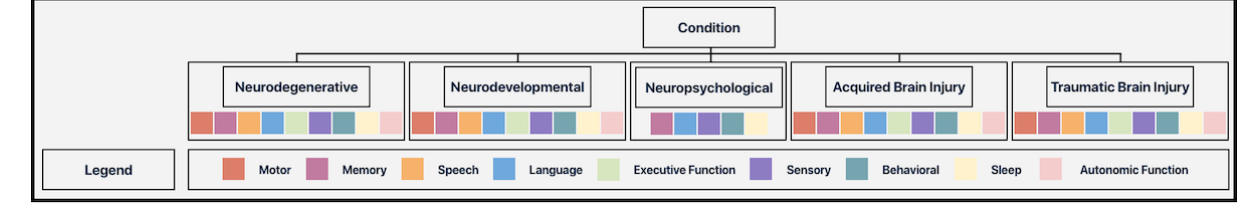
Figure 1. Neurological conditions and the neurocognitive functions they may